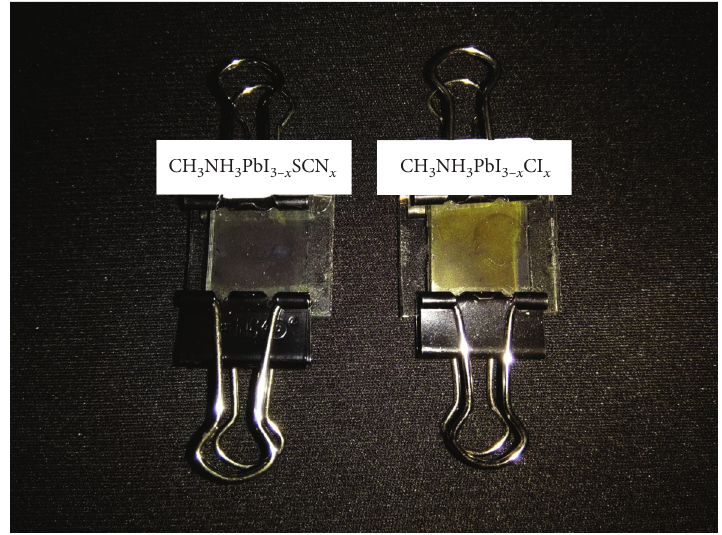
Figure 7: Decomposition of perovskite layer seen on day